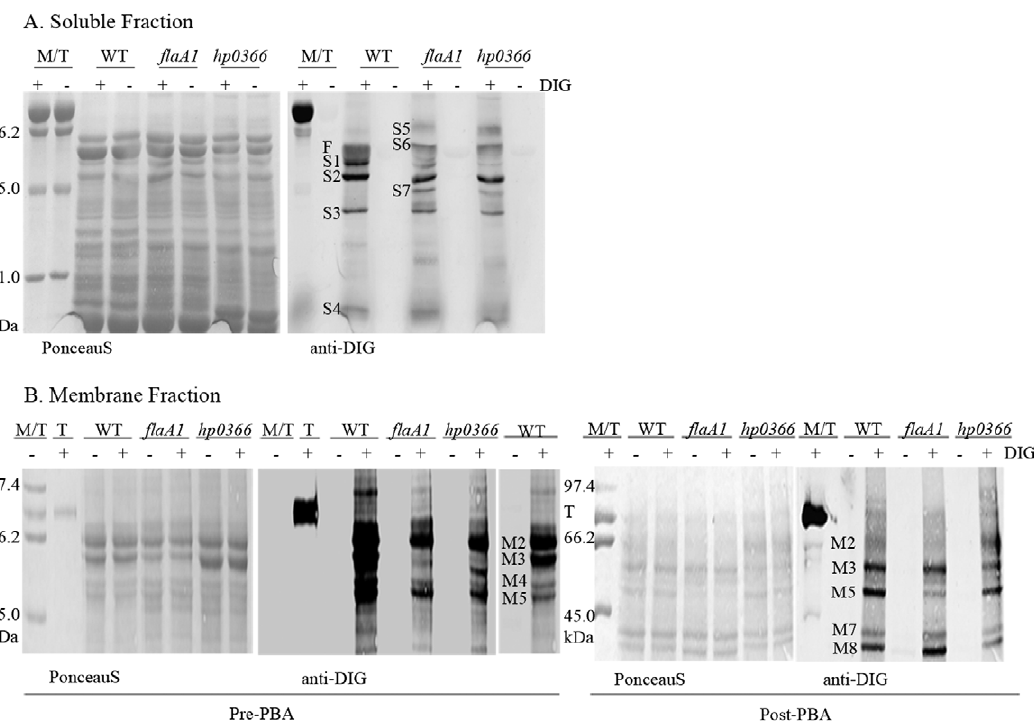
Figure 6. Comparative analysis of the GPs of the soluble and membrane fractions between the WT and flaA1 and hp0366 mutants. Panel A : soluble proteins. Panel B : membrane proteins. The soluble and membrane fractions were prepared as described in Figure 4 . The membrane fractions were run through a phenyl boronic acid (PBA) column (Post-PBA) or not (Pre-PBA) before DIG labeling and SDS-PAGE analysis. Because of the higher DIG-reactivity of the WT membrane fraction compared with the mutants despite equal protein loadings, the WT is shown at two different levels of exposure to allow identification of the bands. For all panels: T: transferrin. F: flagellins. + : DIG labeling. 2 : no DIG labeling.